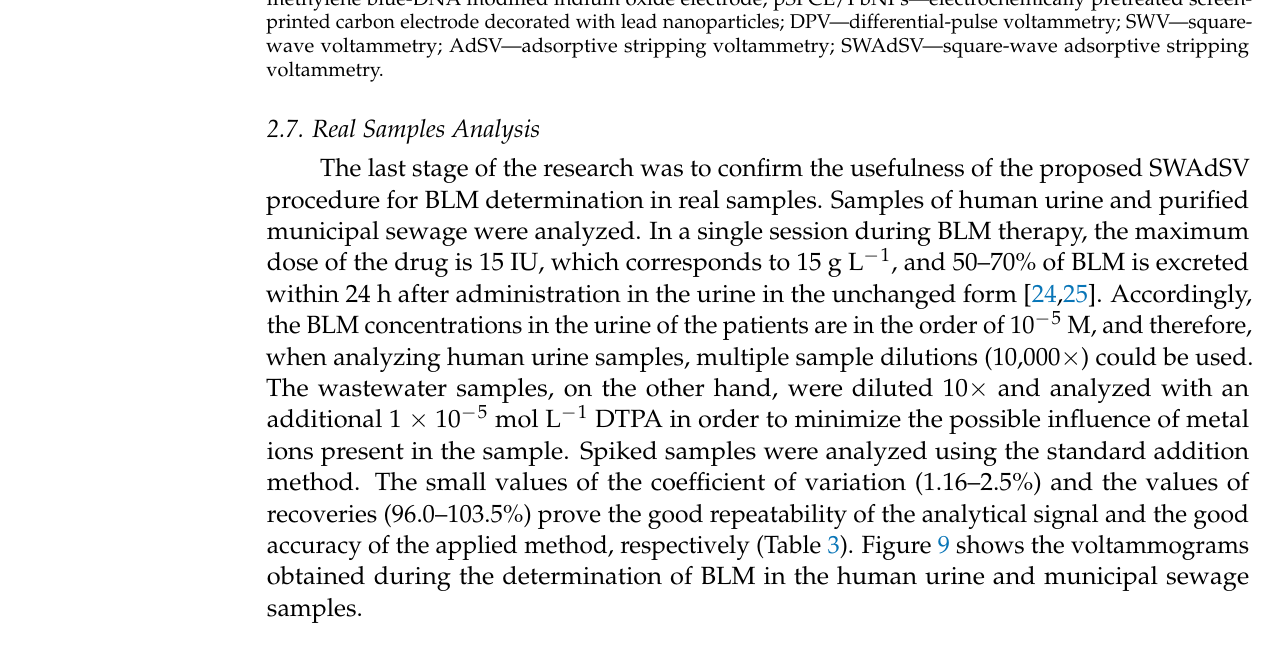
Table 3. The results of BLM determination in reference material of human urine and wastewater purified in a sewage treatment